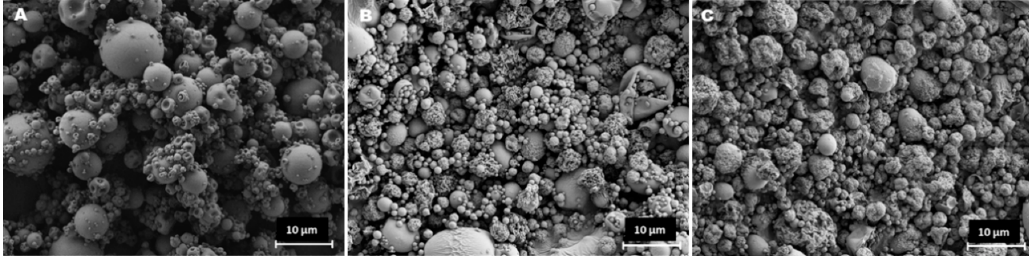
Figure 1. Microphotographs of unloaded chondroitin sulphate (ChS) microparticles ( A ) and ChS/ isoniazid (INH)/rifabutin (RFB) microparticles produced with water-ethanol ( B ) and water-HCl ( C ) as solvents, as obtained by scanning electron microscopy. Scale bar is 10 μ m.